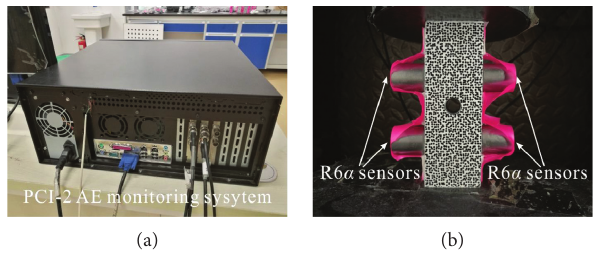
Figure 4: PCI-2 AE system (a) and AE sensor arrangement (b).